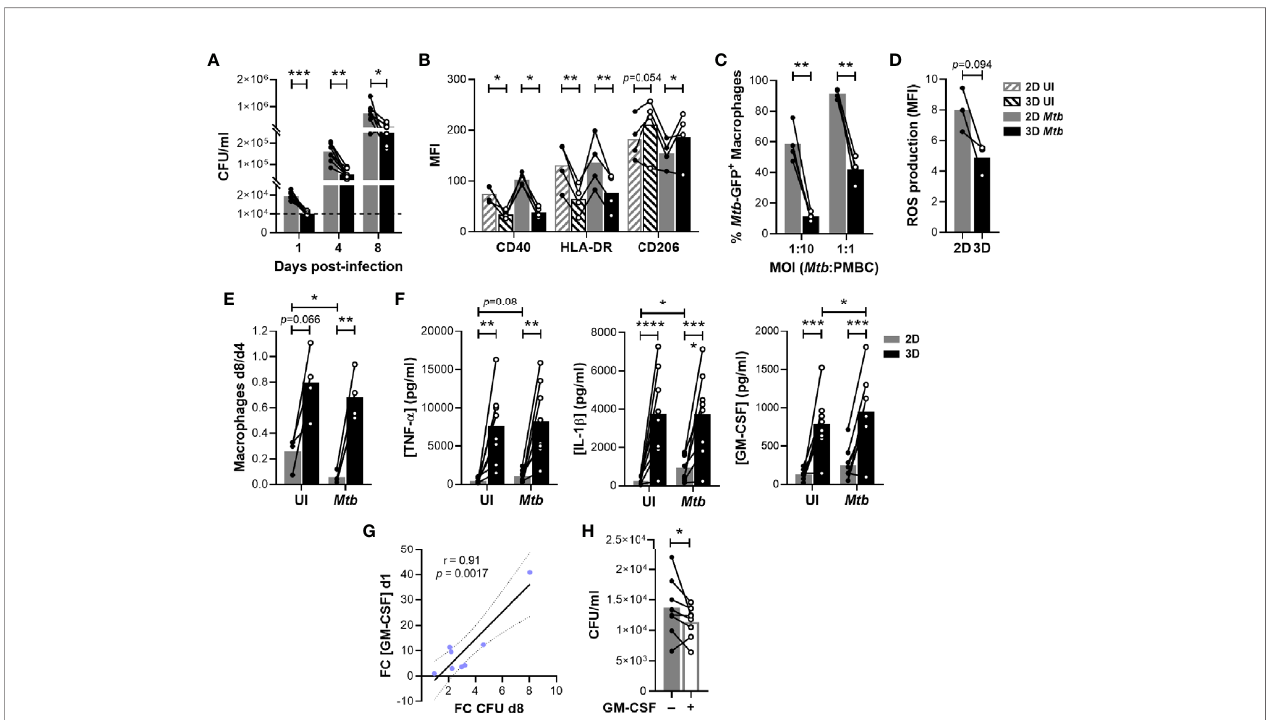
FIGURE 3 | The ECM hinders Mtb growth and enhances macrophage survival by inducing GM-CSF. (A) Quanti fi cation of bacterial load by colony forming unit (CFU) assessment. The dashed line indicates the inoculum. (B) Flow cytometry analysis of the expression of macrophage polarization markers CD40, HLA-DR and CD206 on day 4. MFI, median fl uorescence intensity; UI, uninfected. (C) Flow cytometry analysis of the phagocytic capacity of macrophages retrieved on day 4 and subsequently infected with Mtb H37Ra::GFP. (D) Flow cytometry analysis of ROS production by macrophages retrieved on day 4 and subsequently infected with H37Ra (MOI 1:1). (E) Macrophage survival estimated by fl ow cytometry as the ratio of macrophages remaining on day 8 compared those present on day 4. (F) Concentration of TNF- a , IL-1 b and GM-CSF in the supernatants on day 1 quanti fi ed by multiplex bead-based immunoassay. (G) ECM-induced increase on GM- CSF concentration on day 1 correlates with the decrease in CFU observed on day 8. FC, fold change. Data were analyzed using Pearson ’ s correlation test. Grey dotted lines represent 95% con fi dence intervals. (H) Quanti fi cation by CFU assessment of bacterial load in 2D granulomas after one day of infection in the absence or presence of exogenous GM-CSF (5 ng/ml). (A – F, H) Circles represent the value for each individual donor, lines connect results from the same donor, and bars indicate mean values of eight (A, F) , four (B, C, E) or three (D) donors. Statistical analysis was performed using two-way repeated measures ANOVA and Sidak ’ s multiple comparisons test (A – C, E, F) or paired t test (D, H) . * p < 0.05; ** p < 0.01; *** p < 0.001; **** p <